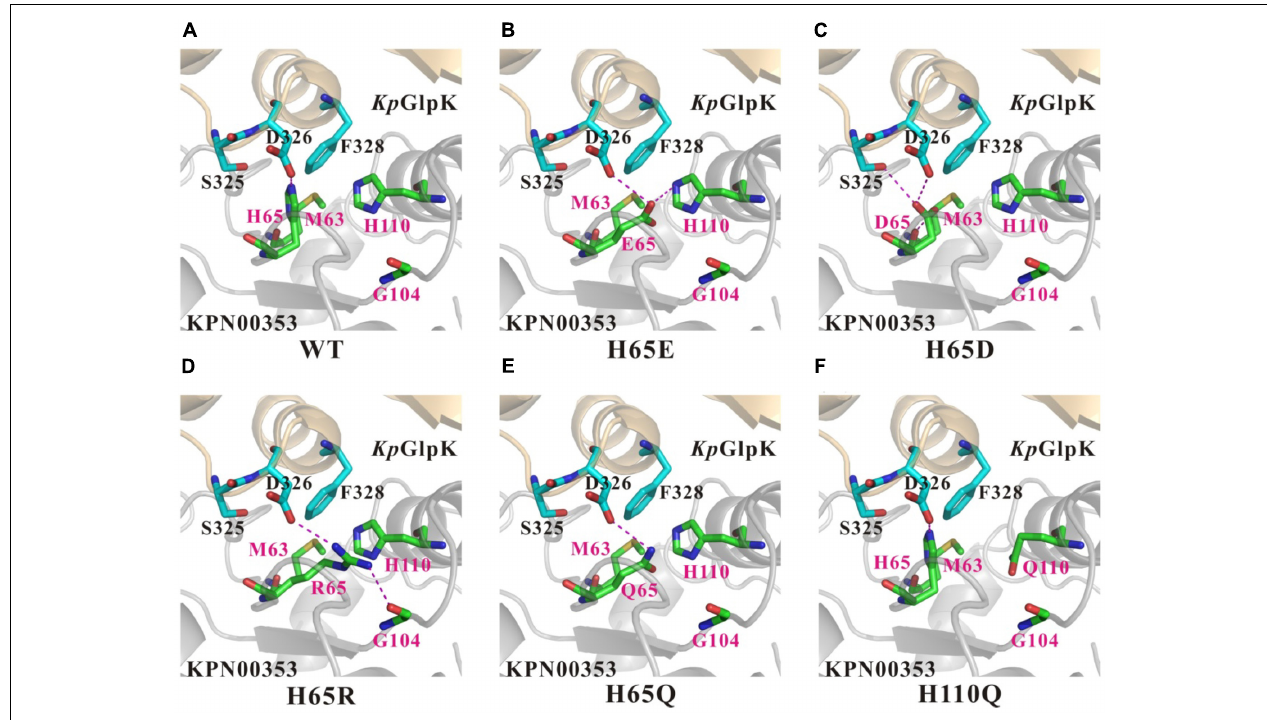
FIGURE 9 | Comparison of the contacts surrounding residues 65 and 110 of KPN00353 variants interacting with K. pneumoniae GlpK. (A) Wild-type KPN00353, (B) KPN00353 H65E mutant, (C) KPN00353 H65D mutant, (D) KPN00353 H65R mutant, (E) KPN00353 H65Q mutant, and (F) KPN00353 H110Q mutant interacting with K. pneumoniae GlpK. The main chain and side chains of the interface residues of the GlpK molecules are shown in cyan (carbon atoms) stick models and labeled in black. The main chains and side chains of the interface residues of the KPN00353 molecules are shown in green (carbon atoms) stick models and labeled in magenta. The critical salt bridges or hydrogen bonds are indicated by magenta dashed lines.